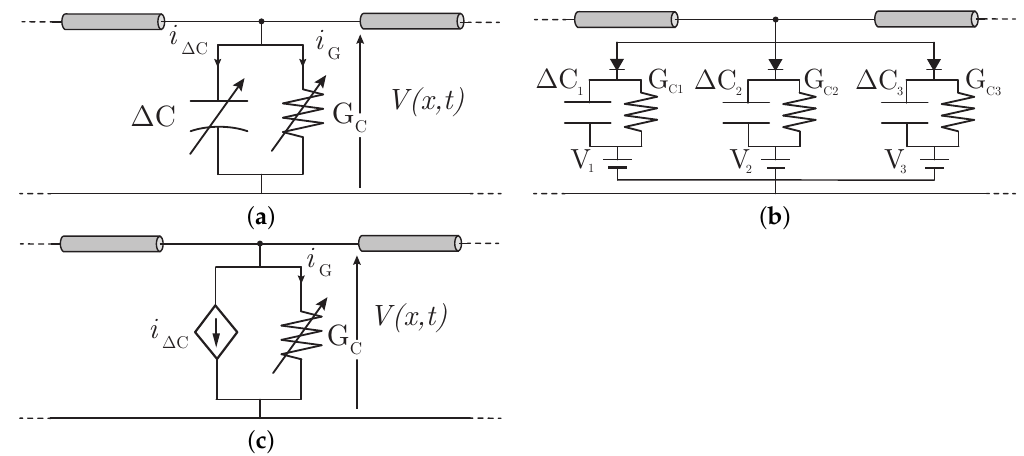
Figure 6. Corona circuit models. ( a ) Hara and Umoto, ( b ) Motoyama and Ametani, ( c ) Maccioni-Araneo et